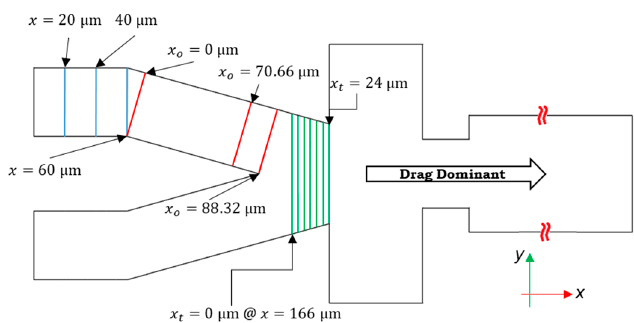
Figure 3. The 12 cross-sections along the length of the channel are used to calculate the lift forces on particles considering trilinear interpolation between these sections. Particles are dominated by the drag force in the right portion of the design after the tapered section; therefore, the e ff ect of lift forces on particle encapsulation is negligible in this zone. Here, x o stands for the local x -coordinate laid in the direction of the oriented channel, and subscript t shows the local x-coordinate of the tapered section.